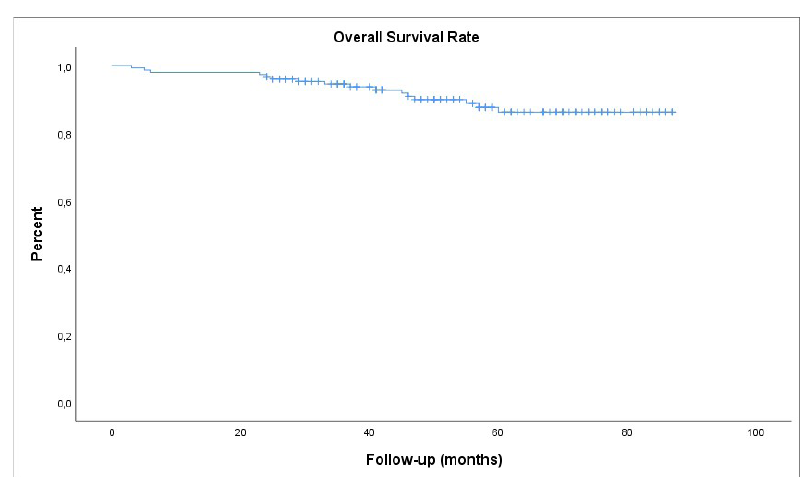
Fig. 1 - Cumulative survival analysis of the patients.